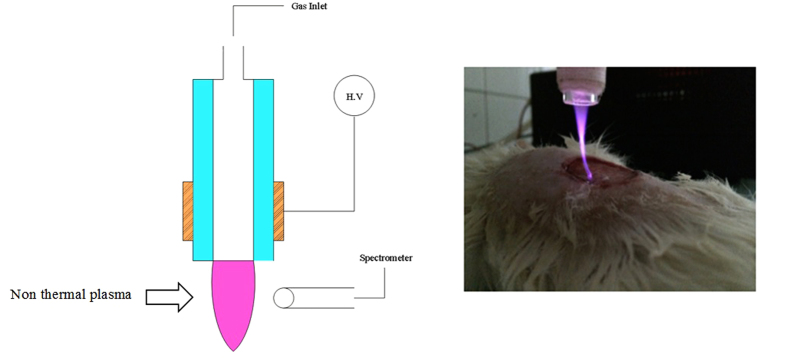
Schematic of plasma setup during an experiment (Left). Real discharge photo of the skin graft (Right).